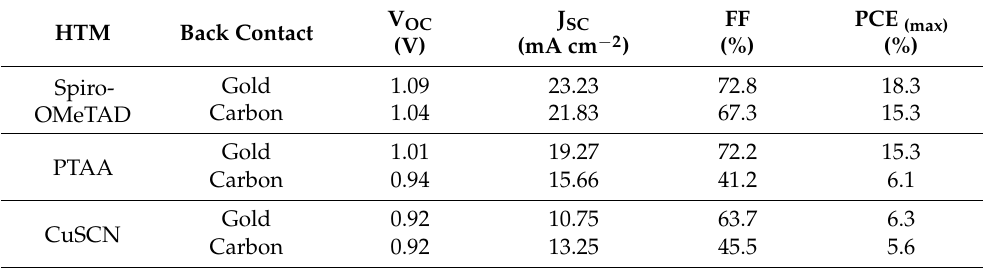
Table 3. J-V parameters of the champion Au and carbon-based devices with different HTMs, including Spiro-OMeTAD, PTAA, and CuSCN.